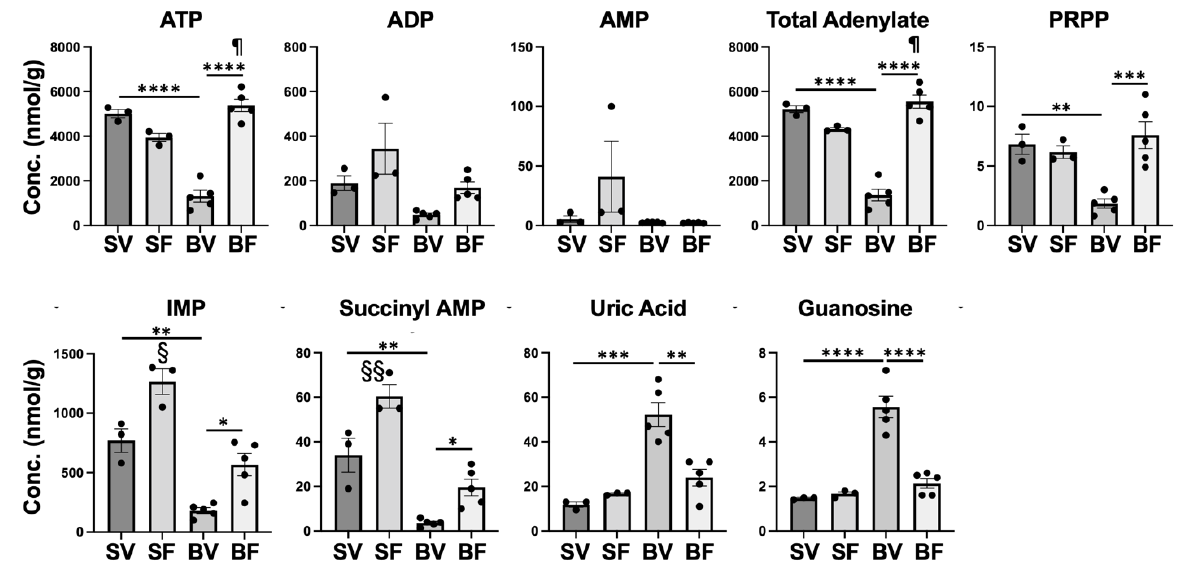
Figure 5. Effects of burn injury and FTI-277 on metabolites related to purine metabolism. SV: Sham- Vehicle; SF: Sham-FTI; BV: Burn-Vehicle; BF: Burn-FTI, Succinyl AMP: adenylosuccinic acid, ** p < 0.01, *** p < 0.001, **** p < 0.0001, § p < 0.05 vs. Sham-Vehicle, p < 0.001 vs. Burn-FTI, §§ p < 0.01 vs. Sham-Vehicle, p < 0.001 vs. Burn-FTI, ¶ p < 0.05 vs. Sham-FTI.